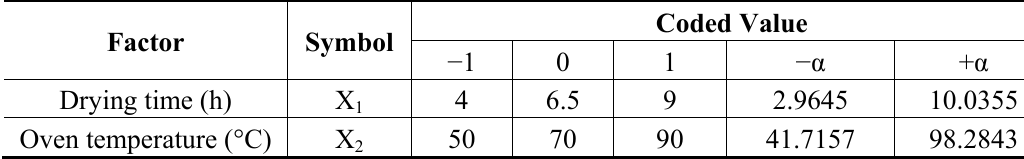
Table 5. Coded value of independent